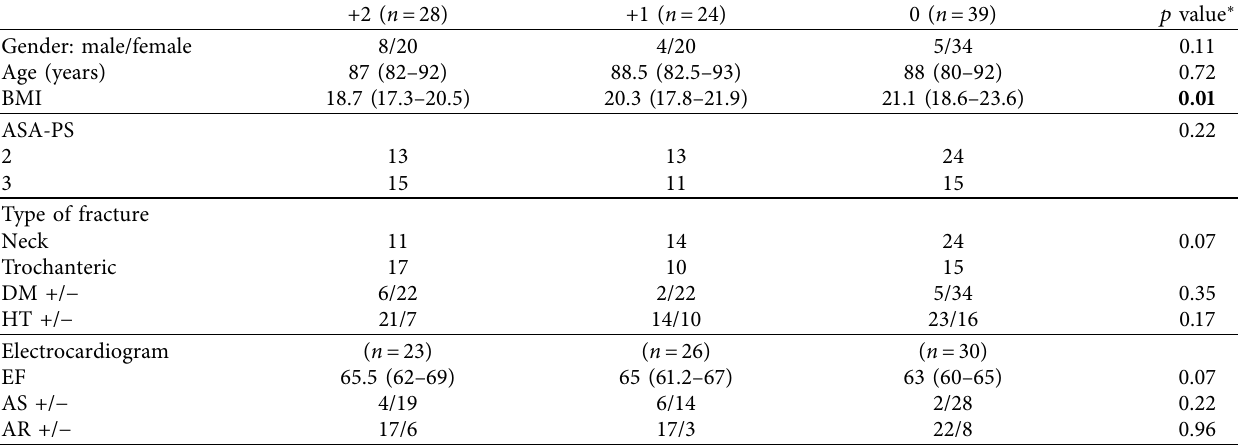
Table 1: Clinical parameters by each classification